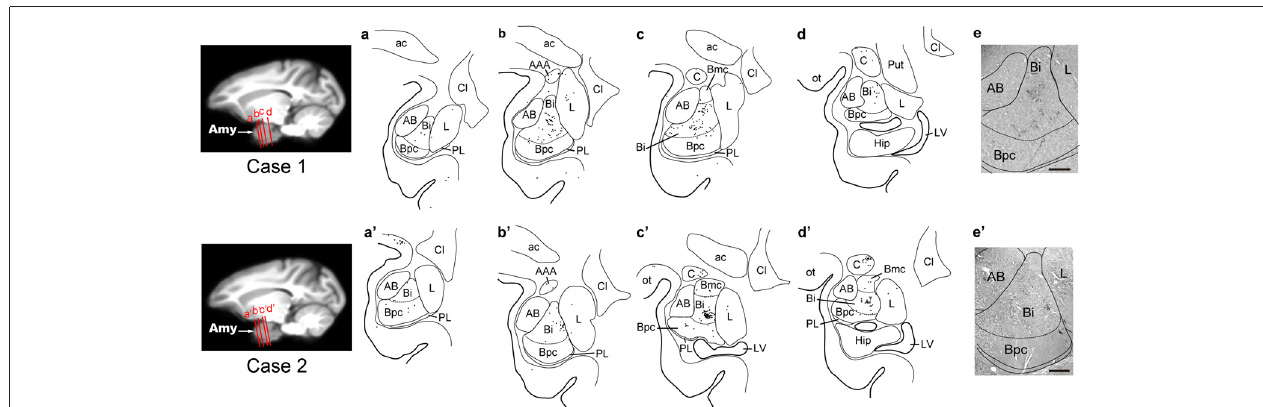
FIGURE 4 | Distribution patterns of the second-order neuron labeling in the amygdala at the 3-day survival period in Case 1 (upper) and Case 2 (lower). In each case, four representative coronal sections are arranged rostrocaudally in (a–d) or (a (cid:48) –d (cid:48) ) . The approximate rostrocaudal levels of the sections are indicated in the MRI template brain of the macaque monkey (left). Each dot represents one labeled neuron. Photomicrographs of the sections (b,b (cid:48) ) are shown in (e,e (cid:48) ) , respectively. AAA, anterior amygdaloid area; Amy, amygdala; Cl, claustrum; Hip, hippocampus; LV, lateral ventricle; ot, optic tract; Put, putamen. Other abbreviations are as in Figures 2 , 3 .